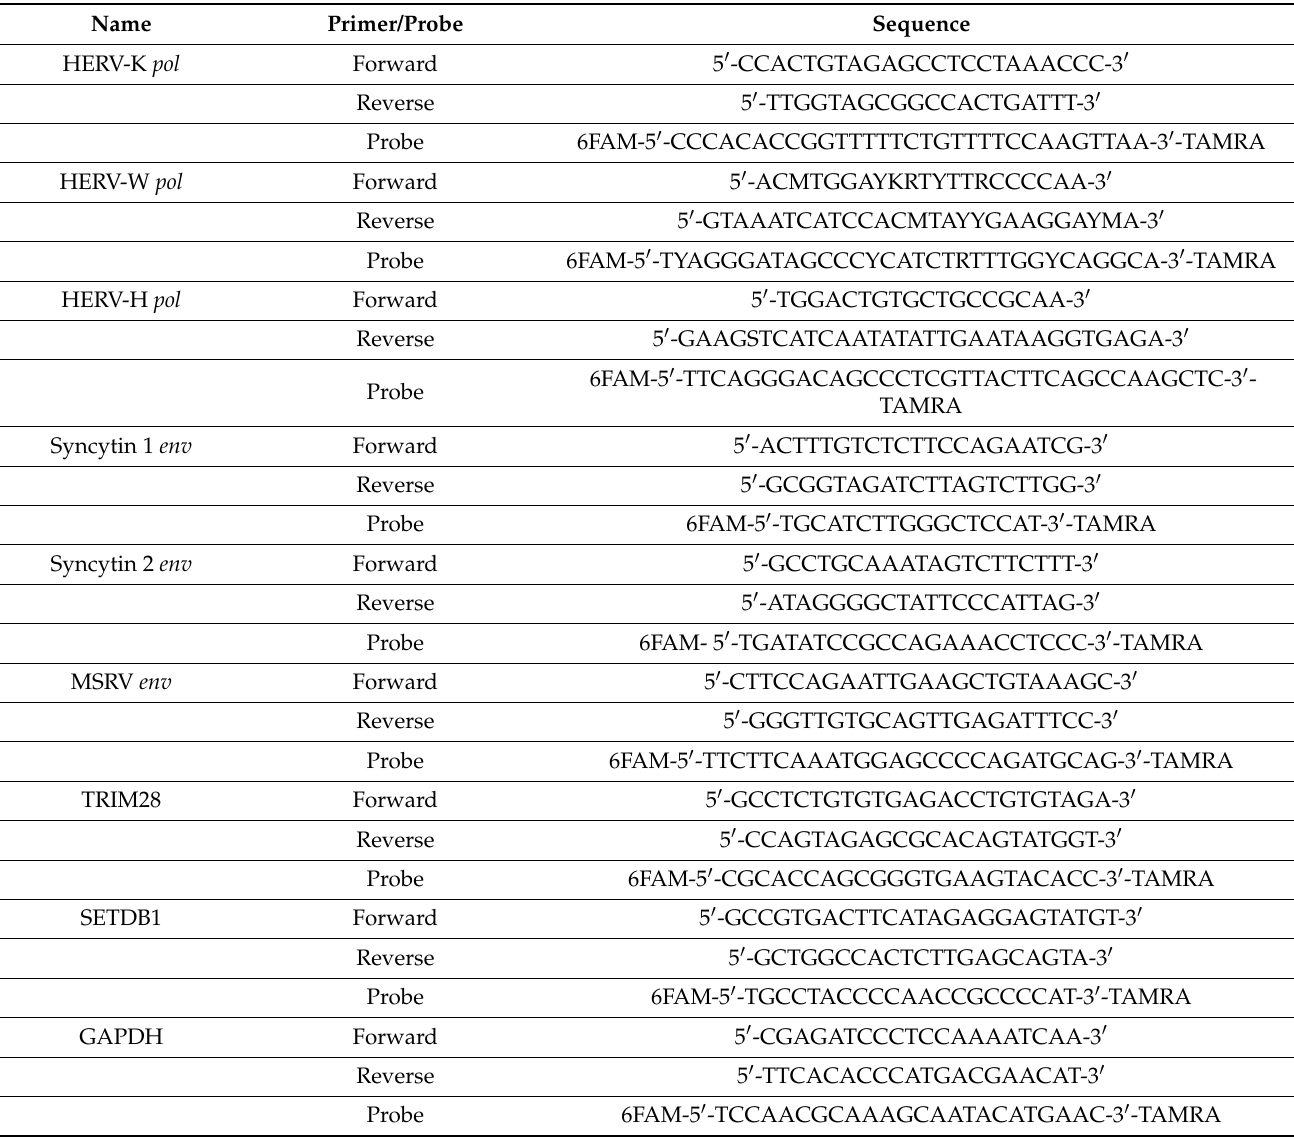
Table 1. Primers and probes used to assess the transcription levels of pol genes of HERV-K, -W, and –H; of env genes of Syncytin 1, Syncytin 2, and multiple-sclerosis-associated retrovirus; and of TRIM28 and